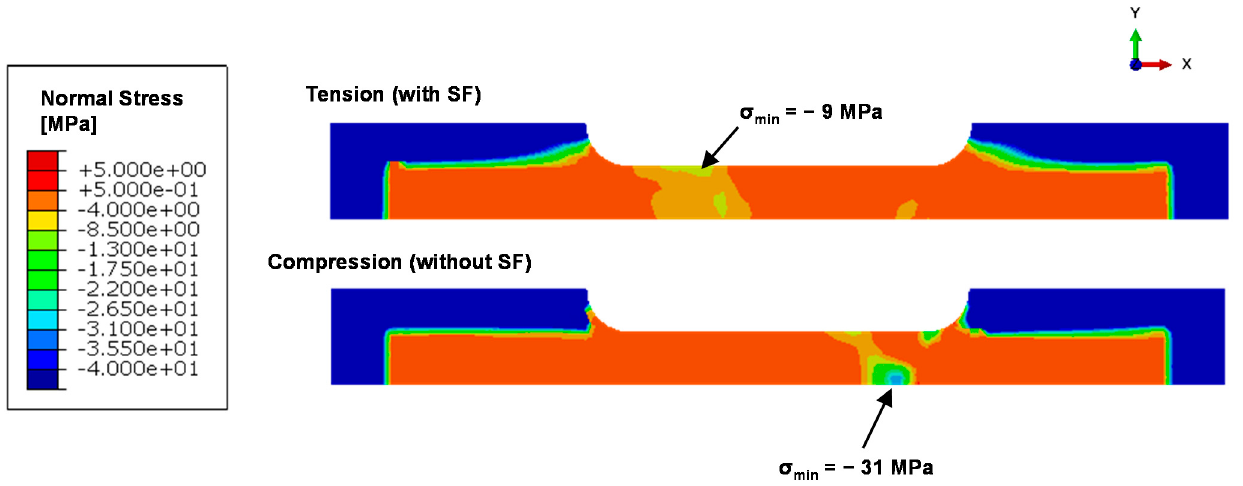
Figure 10. Normal stress distribution during the tensile and compressive tests under side force at the strain of 0.005.